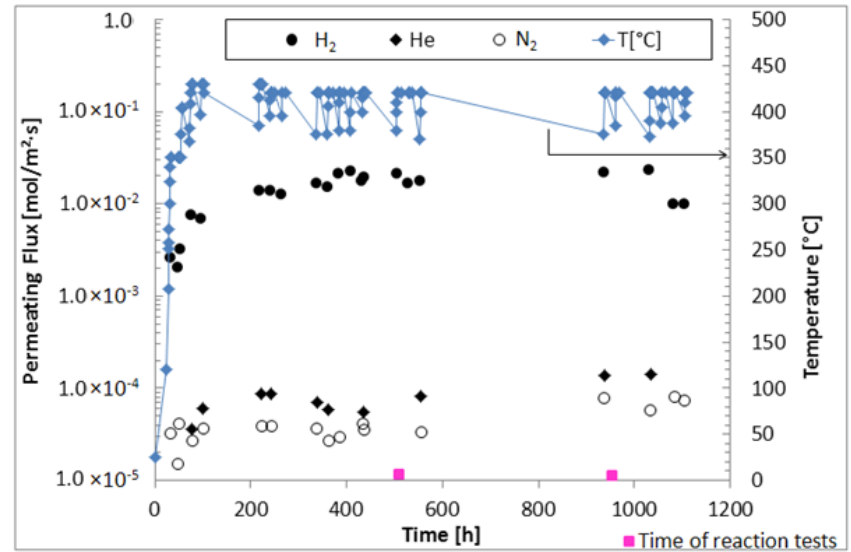
Figure 1. Pure H 2 , N 2 , He permeating fluxes through the Pd ‐ Au/PSS membrane and operating temperature vs. time.